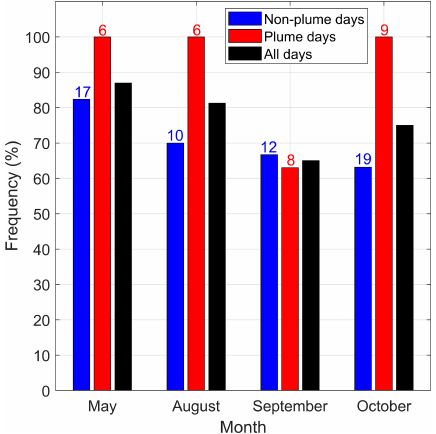
Figure 2. Frequency of occurrence of NPF at Maïdo. Statistics are shown separately for plume and non-plume days, and total frequen- cies are also reported. Numbers on the plot indicate, for plume and non-plume conditions, the total number of days included in the